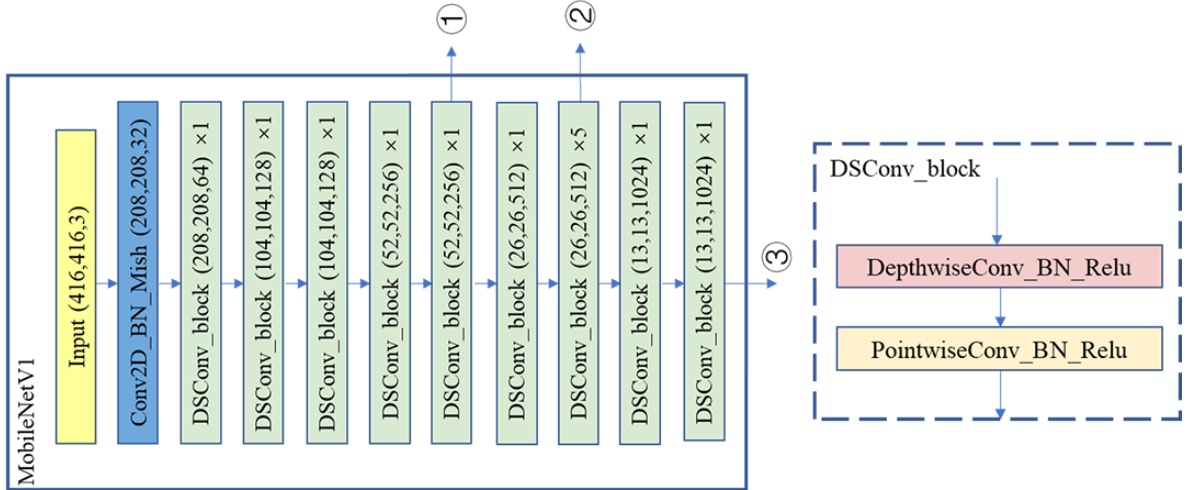
Figure 4. The structure of YoloV4.